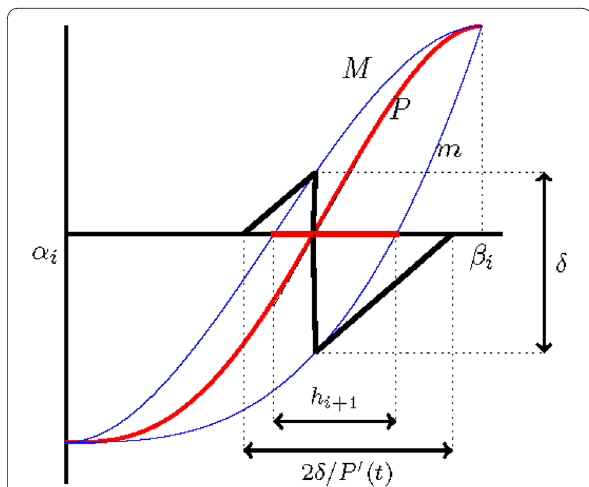
Fig. 4 Illustration of Theorem